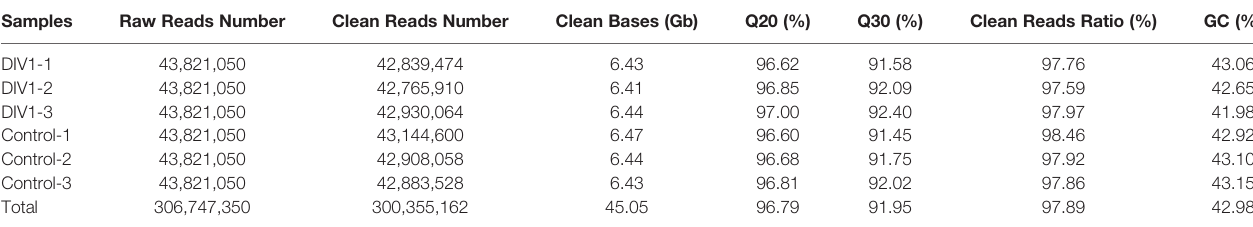
TABLE 2 | Summary of mRNA-seq data. Samples